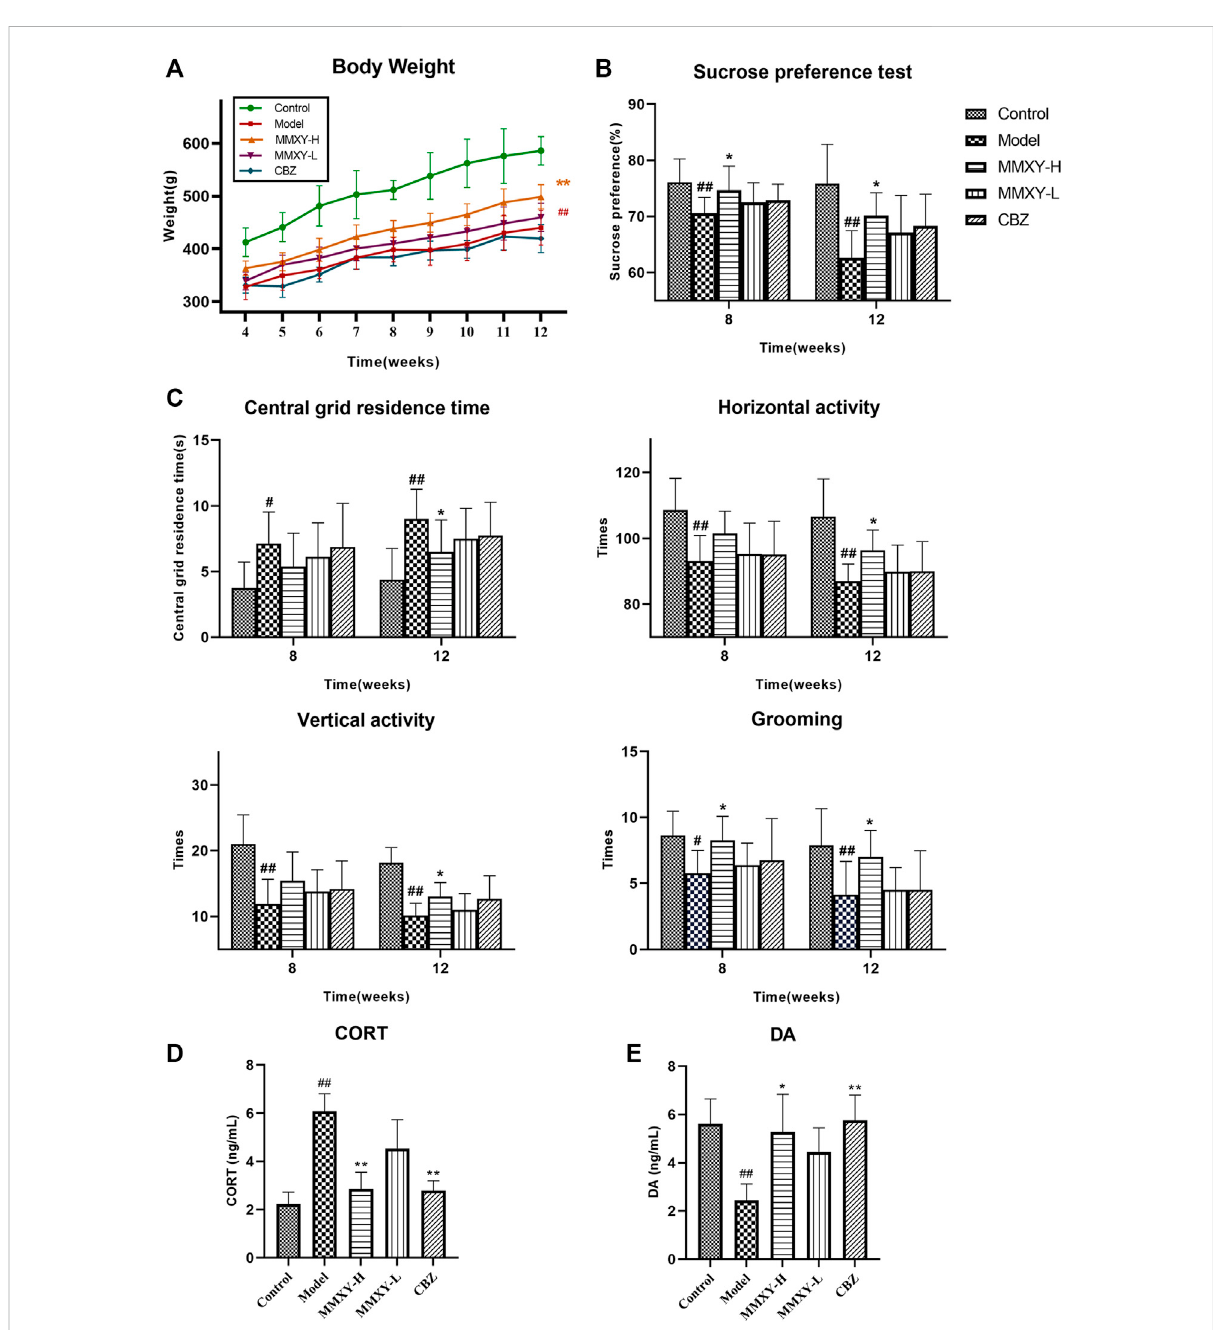
FIGURE 4 At4 – 12 weeks,effectsofMMXYonbodyweight,SPT,OFT,CORTandDAofCUMSratsincontrolgroup,modelgroup,MMXY-Hgroup,MMXY- L and CBZ groups. (A) Weight of rats at 4-12 weeks (n = 8). (B) SPT results at weeks 8 and 12 (n = 8). (C) OFT results at weeks 8 and 12, including the central grid residence time, horizontal activity, vertical activity and grooming times (n = 8). Results are shown as the mean ± SD. # p < 0.05 and ## p